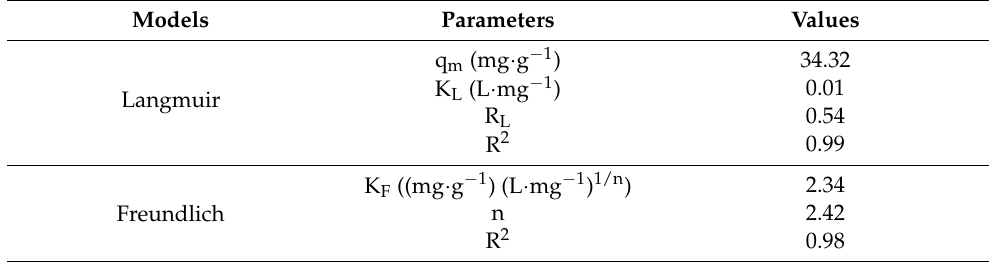
Figure 4. Adsorption isotherms of NaCl adsorbed by ACA. Table 3. Parameters of Langmuir and Freundlich isotherm models for the adsorption of NaCl.